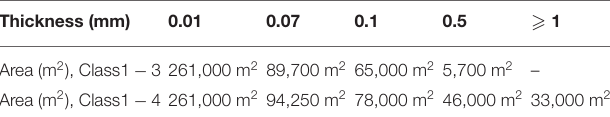
TABLE 2 | Surface area covered by different thicknesses of sediment